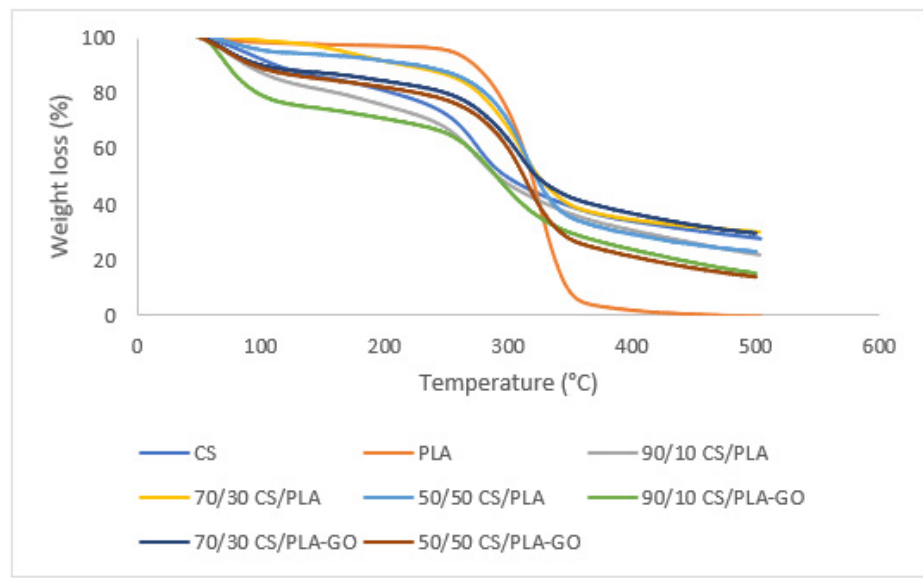
Figure 4. TGA thermograms of CS, PLA and CS/PLA with and without GO composites.